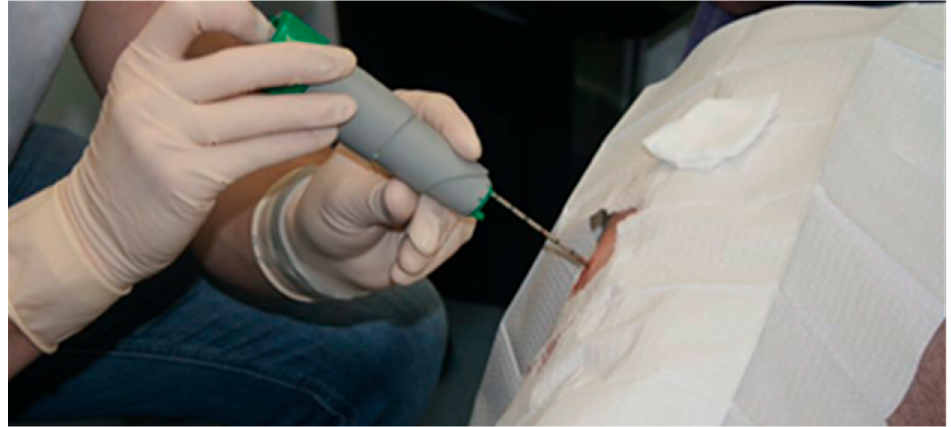
Figure 5. Illustrates the Monopty 12 G, disposable core biopsy instrument (BARD, Brighton, UK) being used on an athlete’s vastus